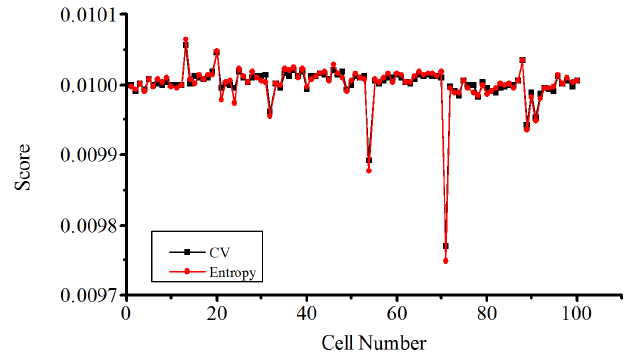
Figure 10. Comparison curve of the coefficient of variation (CV) and entropy method of Vehicle 2 on